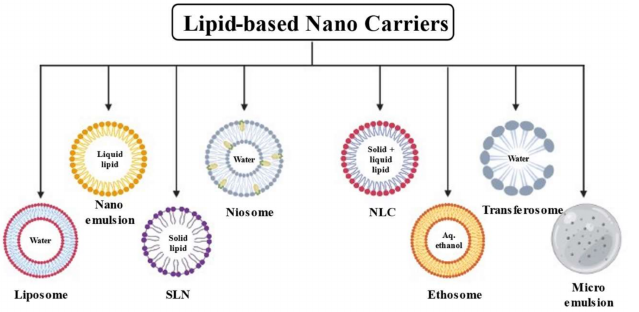
Figure 1. List of lipid-based nanocarriers used for delivery of pharmaceutically active